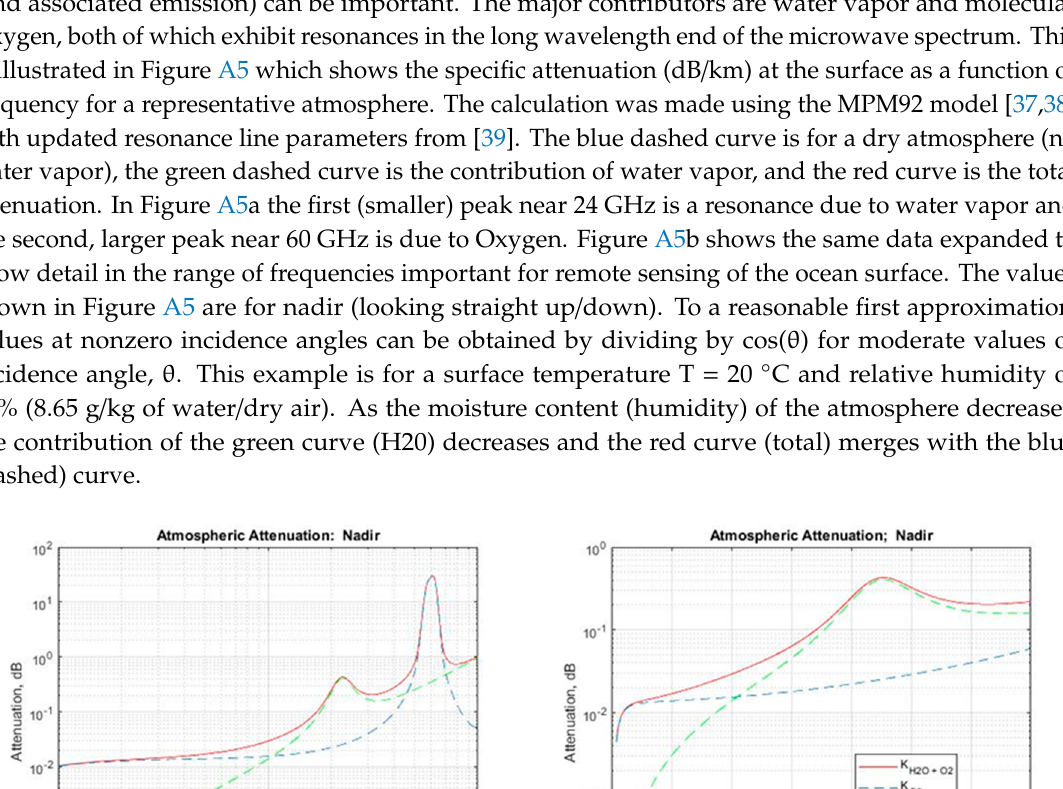
Figure B2. Dependence on salinity of the sensitivity of brightness temperature to changes in salinity, dTB/dSSS, as a function of frequency. The examples are for nadir, SST = 25 ℃ and WS = 0 m/s and made using the Klein-Swift model function [19].